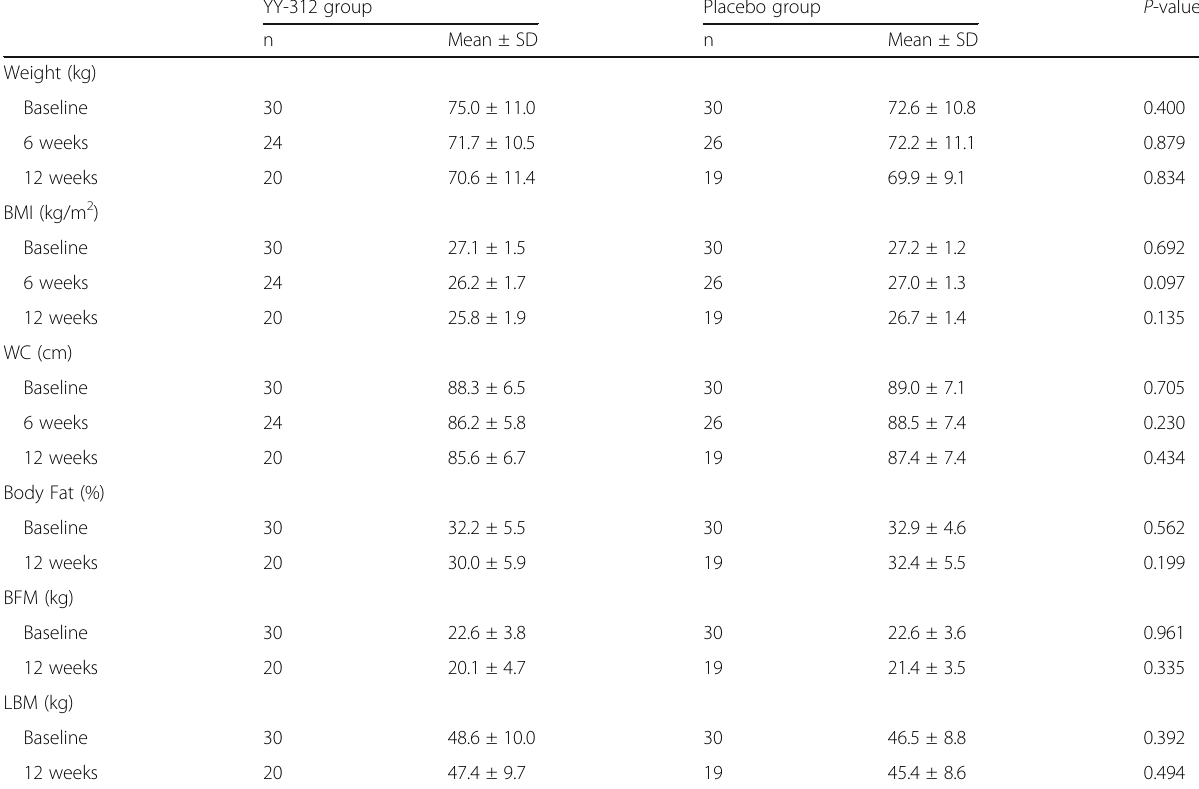
Table 3 Anthropometric and body composition measures by group and visit